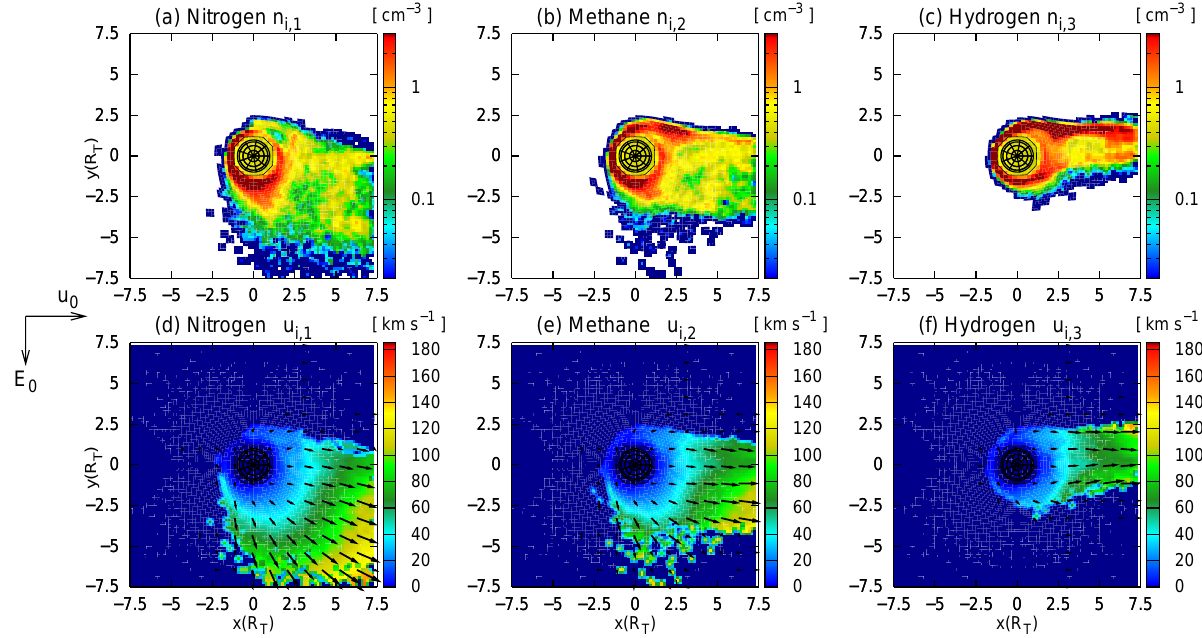
Fig. 10. Run #4 : Titan’s plasma environment under the influence of a periodic distortion according to eq. (12). The period T = 2 π/ω of the distortion is T = 3500 δt . The figure shows the ionospheric plasma parameters that correspond to Fig. 9.